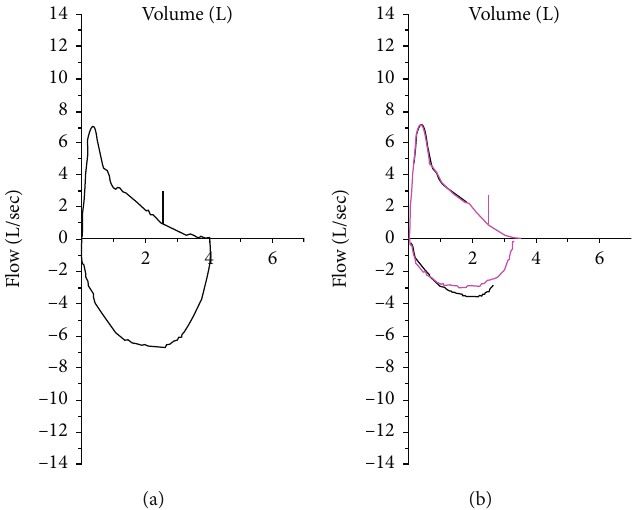
Figure 2: (a) Spirometry during acute admission with cough, wheeze, and shortness of breath. Spirometry indicates obstructive airways with raised FeNO supporting a process of in fl ammation in the airways. (b) Spirometry 6 months after acute episode requiring admission, values now normal including the